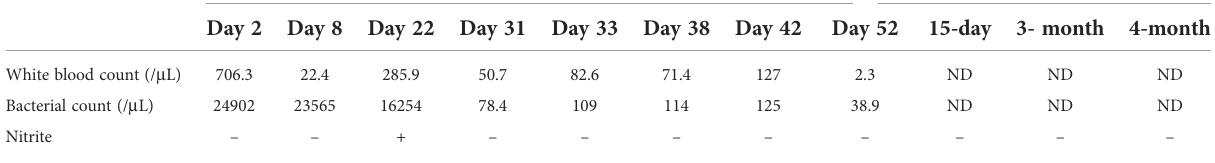
ND, no detected; “ + ” represents positive, “ - ” represents negative.